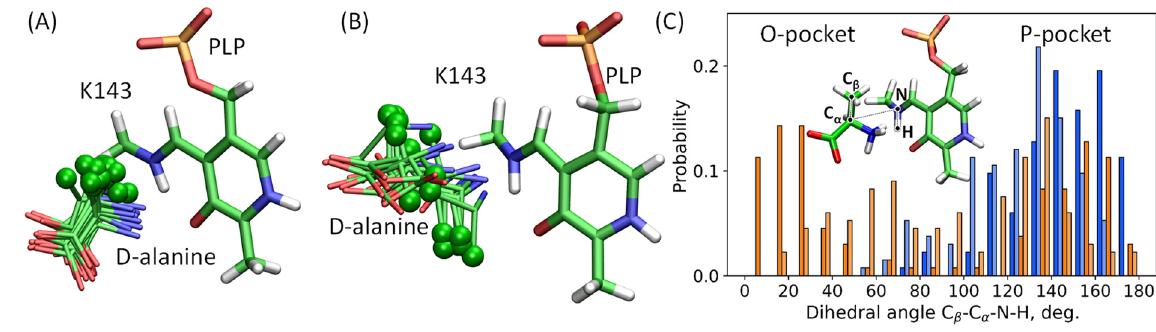
Figure 6. Alignment of multiple frames from the MD runs of the ES complex of WT Halhy ( A ) and the R179G variant ( B ) with D-alanine. ( C ) Distributions of dihedral angles illustrating the orientation of D-alanine. Smaller values correspond to the side chain binding to the O-pocket, larger values—to the P-pocket. Blue bars are for the WT Halhy and orange for the R179G variant. Darker and lighter bars of the same color correspond to the different subunits.